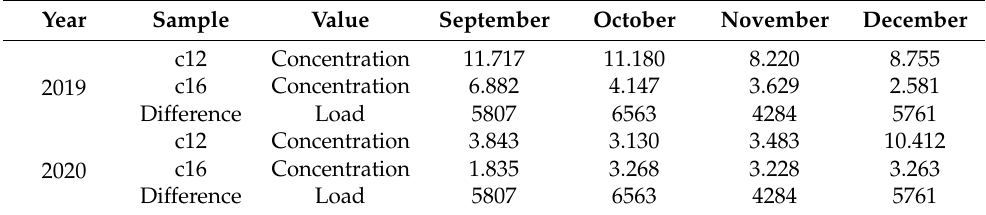
Table 3. NO 3 − concentrations and loads during the autumnal fertilization period in 2019 and